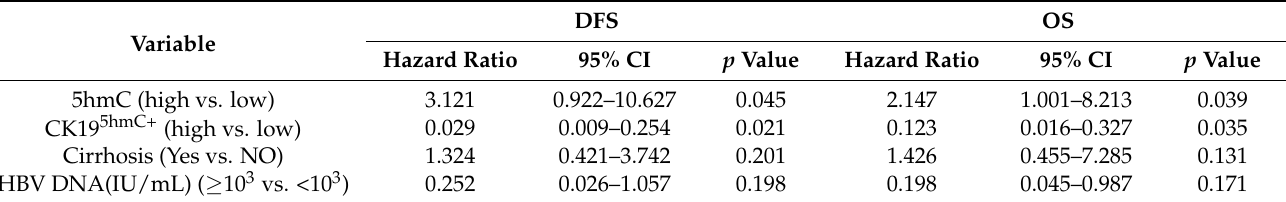
Table 3. Multivariate cox analysis on DFS and OS of